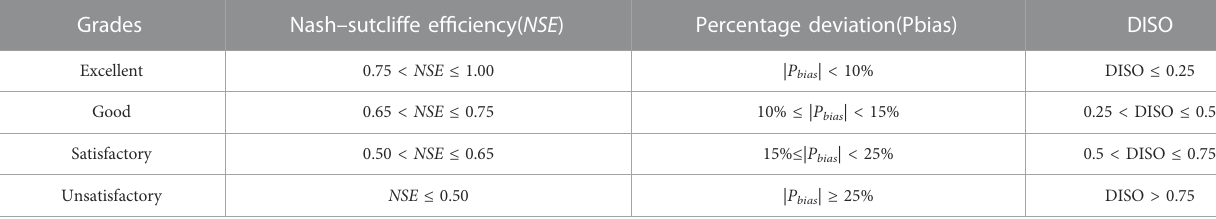
TABLE 2 Grading criteria based on the assessment of R act in the ICL models. Grades